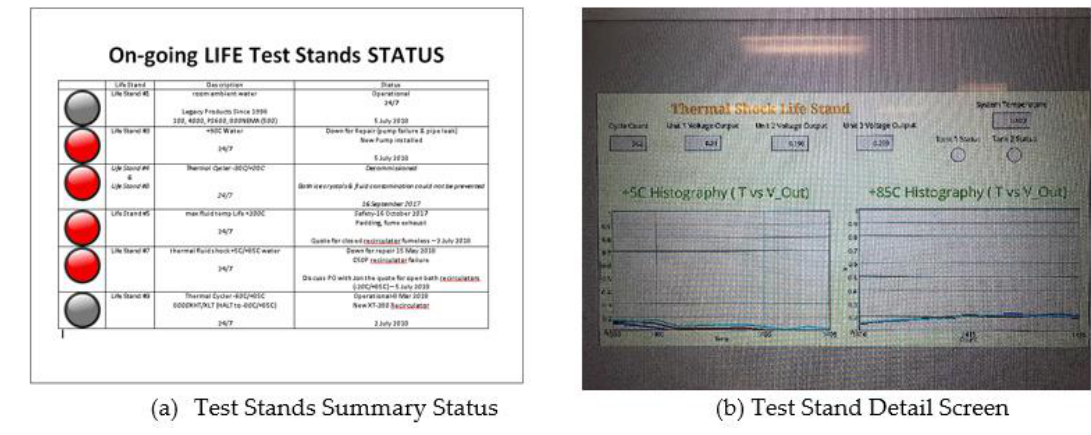
Figure 8. State of Each Life Test Stand. ( a ): Executive Summary Status of all Life Test Stands; ( b ): Detailed Status of Thermal Shock Life Test Stand.